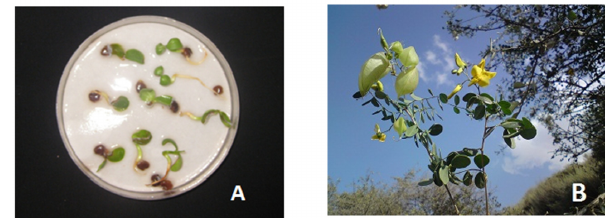
Fig. 3. Seeds germination in laboratory conditions (A) and